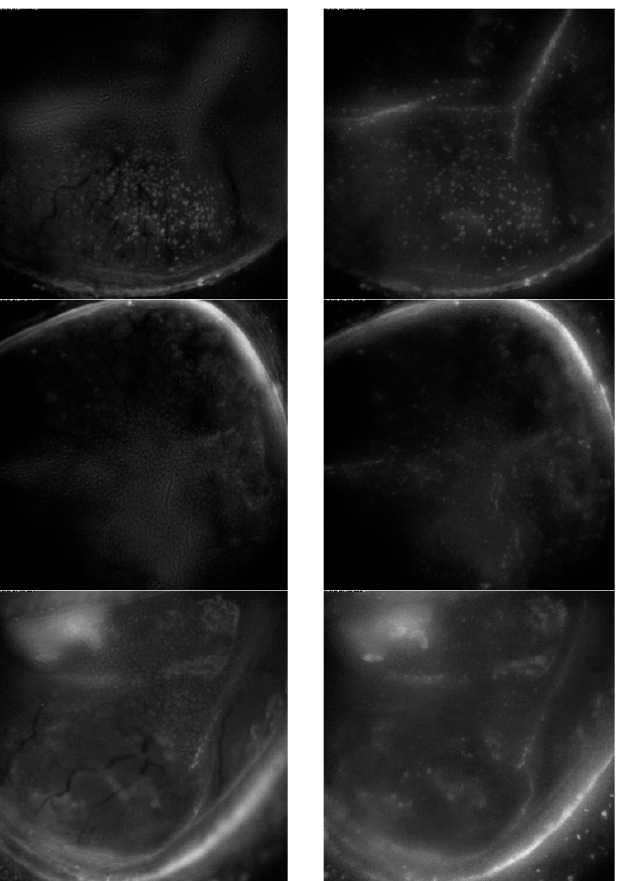
Table 3. Blind image quality evaluation results for first dataset of conjunctival goblet cell images.